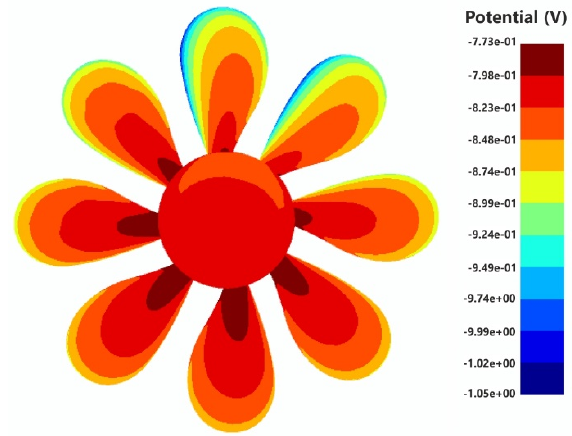
Figure 14. Potential distribution φ (V vs Ag/AgCl/seawater) at the NAB main propeller.